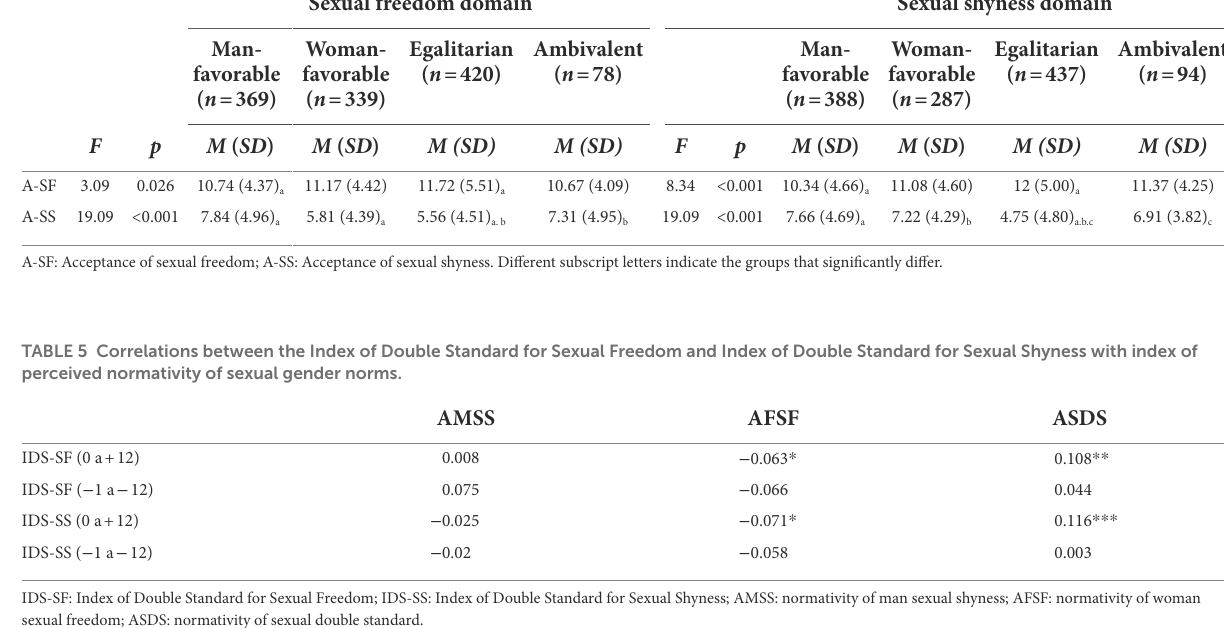
TABLE 4 Differences in sexual freedom and sexual shyness acceptance across SDS adherence typologies.